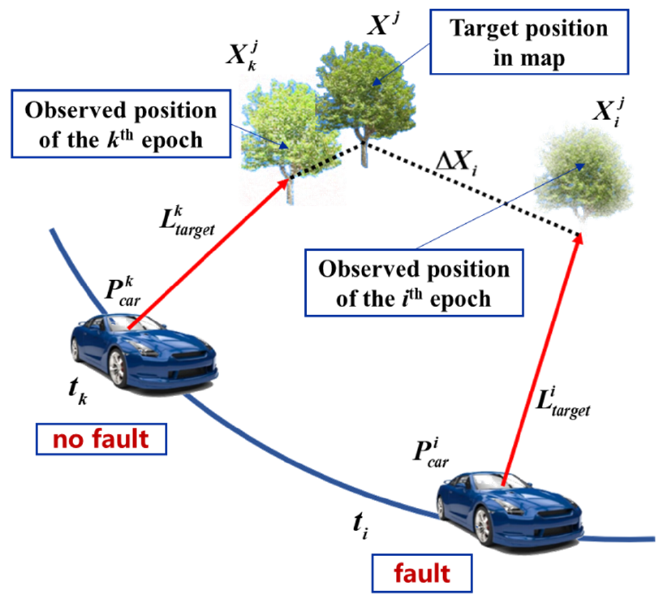
Figure 2. Schematic diagram of the fault detection process aided by LiDAR.